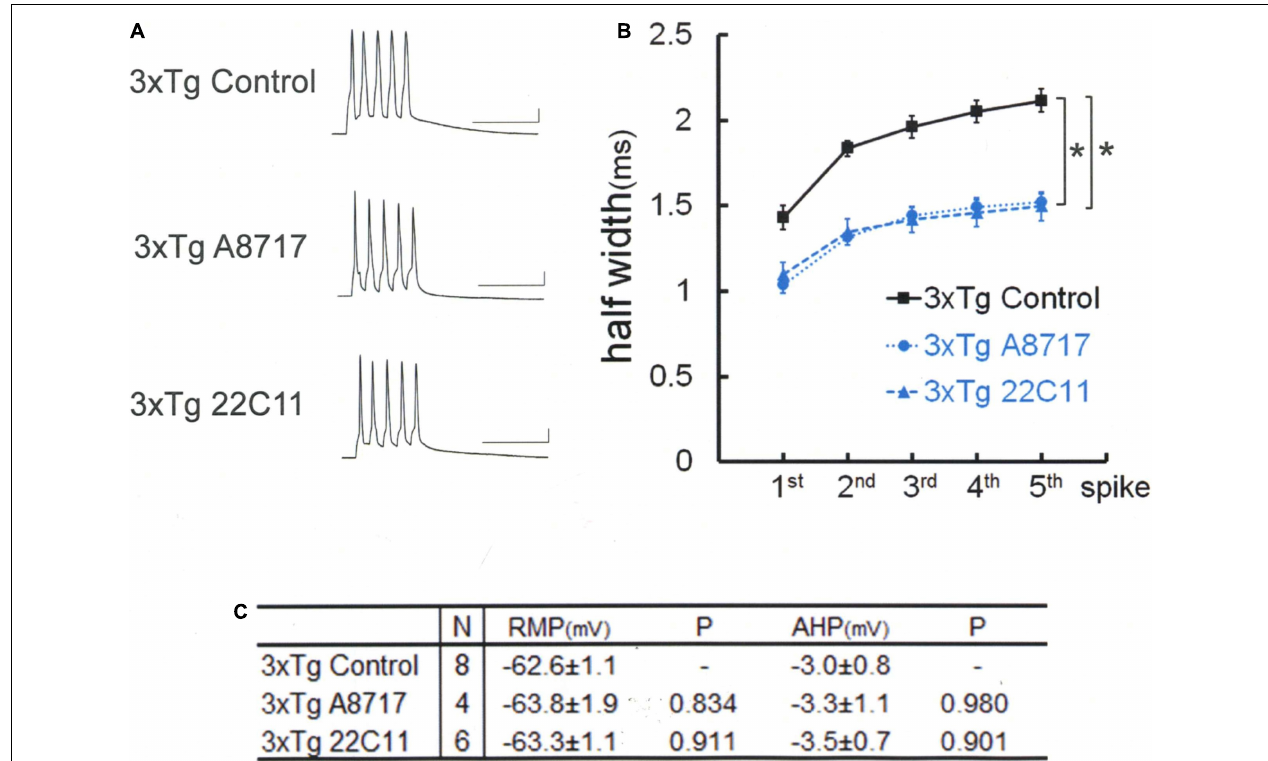
FIGURE 3 | Amyloid precursor protein (APP) N-terminal (22C11) and C-terminal (A8717) antibodies reverse spike broadening in 3xTg mouse neurons. (A) Specimen recordings with anti-APP antibody injected. Scale bars, 50 ms and 20 mV. (B) Averaged spike half-width during the five-spike train (black line and square, 3xTg Control; blue dotted line and circle, 3xTg A8717; blue dashed line and triangle, 3xTg 22C11). Both 22C11 and A8717 are effective (spike half-widths in 5th spikes; * P < 0.001, vs. Control). (C) Basic membrane properties of recorded neurons. Convention is the same as in Figure 1